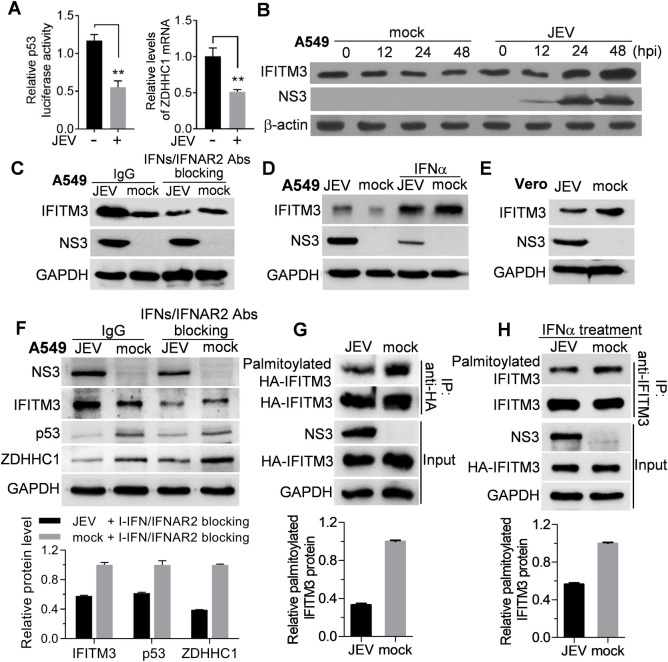
Down-regulation of the p53-ZDHHC1-IFITM3 pathway by JEV infection.(A) A549 cells were transfected with p53 luciferase reporter plasmid for 24 h and subsequently infected with JEV at 2 MOI for 48 h, the relative luciferase activity was measured (left panel); A549 cells were infected with JEV at 2 MOI for 48 h, ZDHHC1 mRNA was detected by qRT-PCR (right panel). Unpaired t test, *P<0.05; **P<0.01. (B) The change of IFITM3 protein expression in A549 cells infected with JEV at 2 MOI was determined by western blot at the indicated times. (C) A549 cells were infected JEV at 2 MOI and simultaneously added I-IFN/IFNAR2 Abs for 48 h, IFITM3 expression was measured with western blot. (D) A549 cells were infected JEV at 2 MOI and simultaneously added 1000 U IFN-α for 48 h, IFITM3 expression level was measured. (E) Vero cells were infected with JEV at 2 MOI for 48 h, IFITM3 protein abundance was detected with western blot. (F) A549 cells were infected with JEV at 2 MOI and simultaneously added I-IFN/IFNAR2 Abs for 48 h, p53, ZDHHC1 and IFITM3 expression were measured with western blot, and relative protein expression normalized to GAPDH under I-IFN/IFNAR2 Abs blocking was analyzed. (G) A549 cells were transfected with HA-IFITM3 for 12 h and subsequently infected with JEV at 2 MOI for 48 h, the palmitoylated HA-IFITM3 level was detected by protein palmitoylation assay. (H) A549 cells were infected with JEV at 2 MOI and simultaneously added 1000 U IFN-α for 48 h, the palmitoylated IFITM3 level was detected by protein palmitoylation assay.